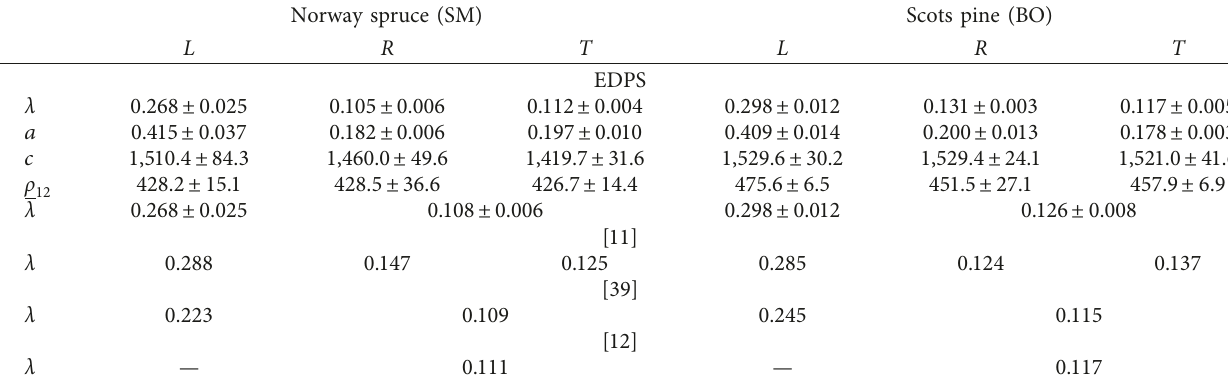
Table 3: Average thermophysical properties of Norway spruce (SM) and Scots pine (BO) at the moisture content of 12% determined by the EDPS method, models, and national building standard.